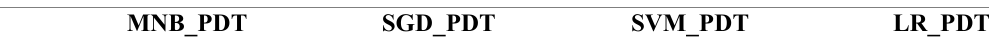
Table 6. In-domain classification results using the proposed